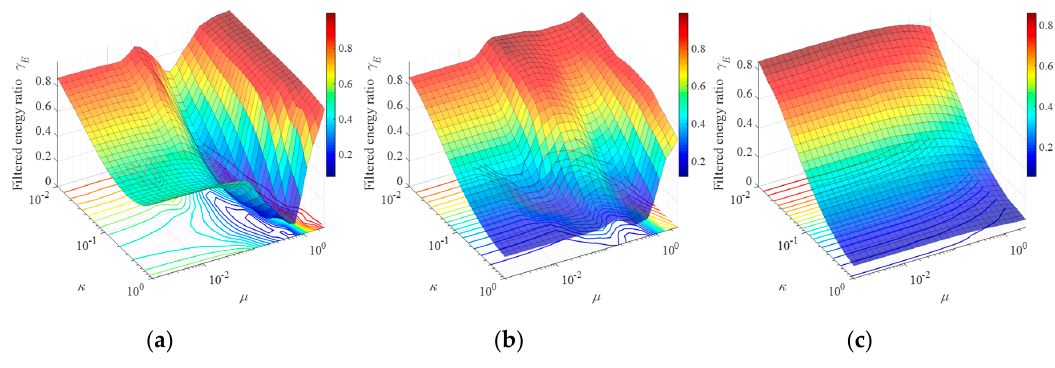
Figure 8. Variation of γ for: (a) λ= 0.2 , (b) λ= 1.00 , and (c) λ= 1000 .